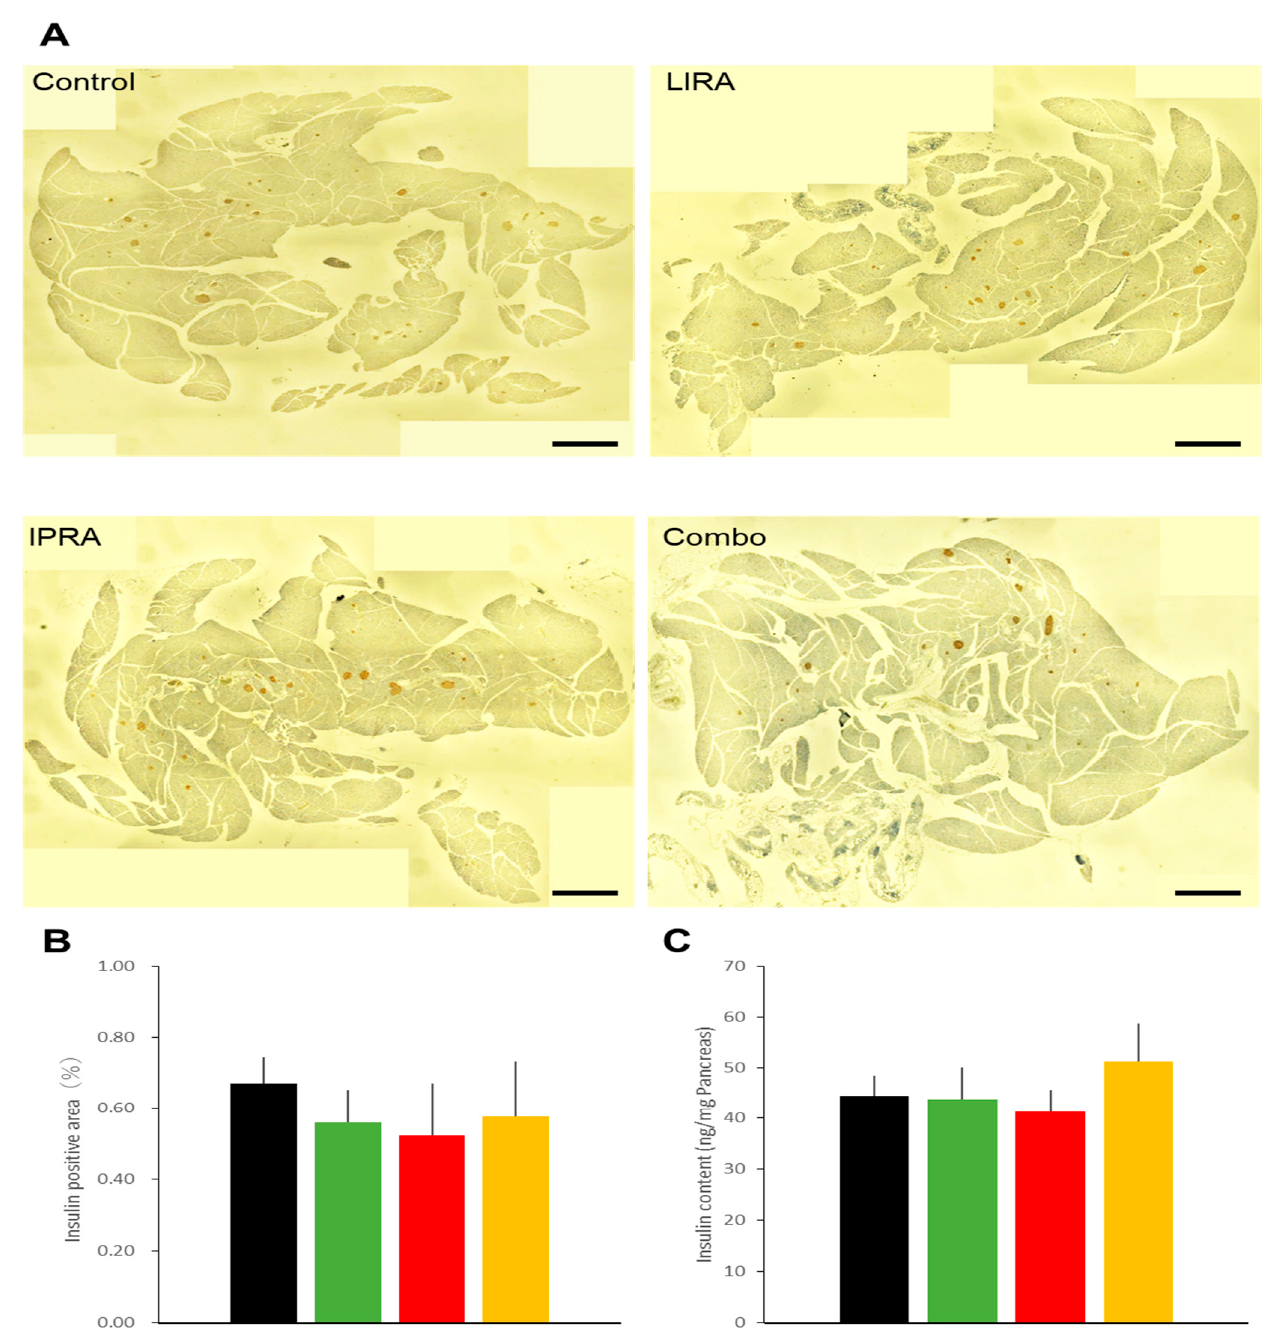
Figure 2. Effects of treatments with liraglutide and/or ipragliflozin on pancreatic islets in DIO mice. Representative pancreatic sections ( A ), insulin positive areas ( B ), and insulin contents ( C ) of vehicle-treated DIO mice and those treated with liraglutide and/or ipragliflozin. n = 4~5 DIO mice per group. Scale bars = 500 µ m. In addition to data from the mice presented in other experiments, another cohort was established to examine the pancreatic effects of these interventions, since insulin positive areas and insulin content cannot be obtained simultaneously from one mouse. Effects on glycemic control in this additional cohort did not differ from other cohorts.